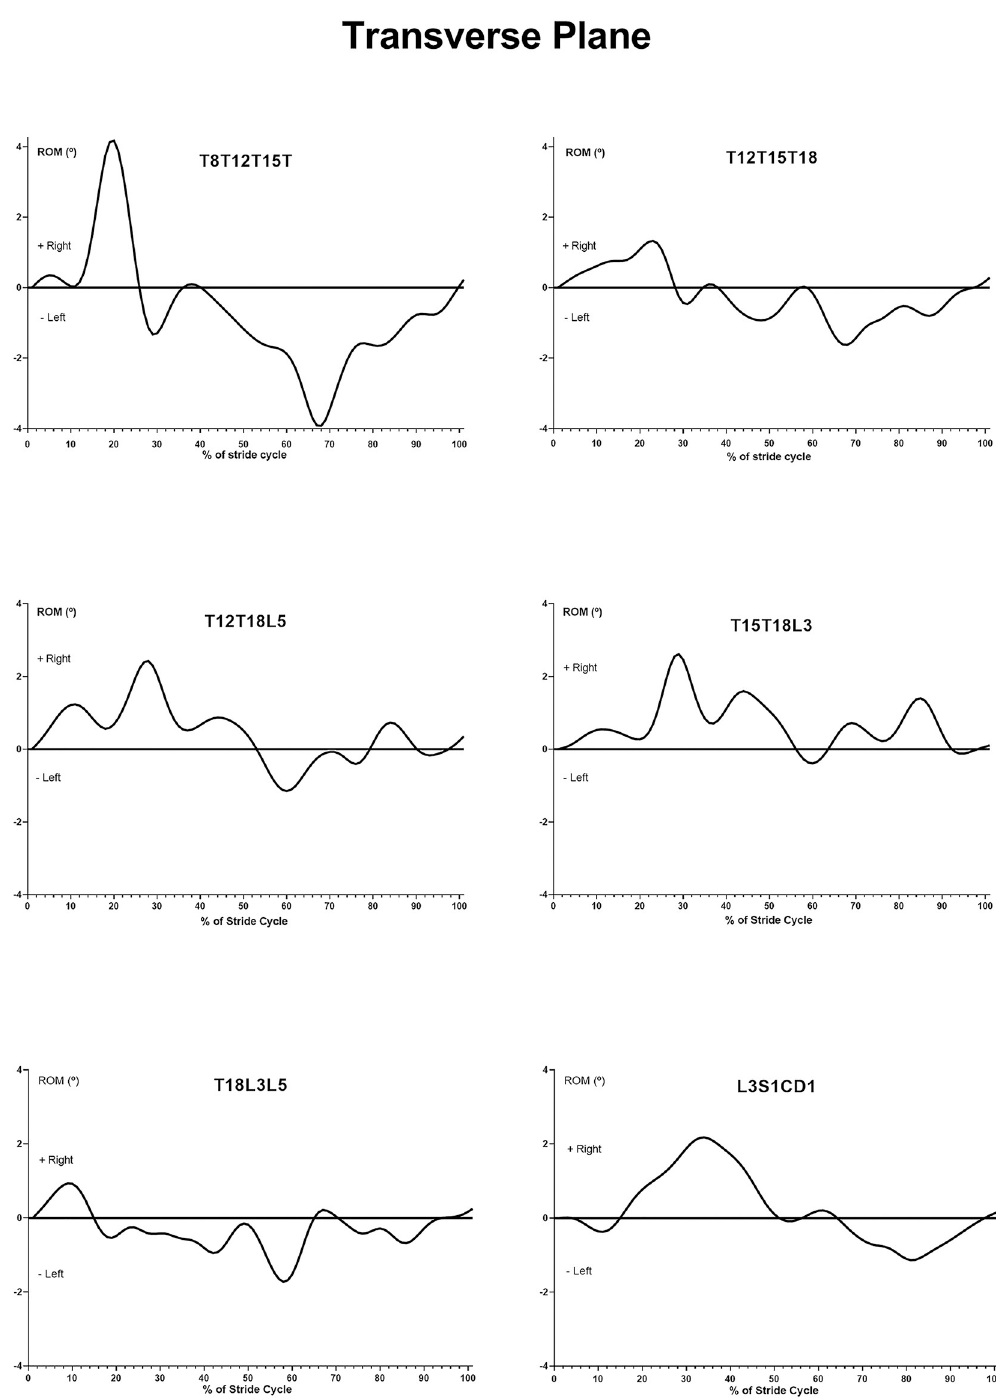
Fig 5. Typical example of mean curve of angular motion pattern (AMP) of the T8-T12-T15, T12-T15-T18, T12-T18-L5, T15-T18-L3, T18-L3-L5 and L3-S1-Cd1 angles, in the transverse plane, in relation to the average of both stride cycles.